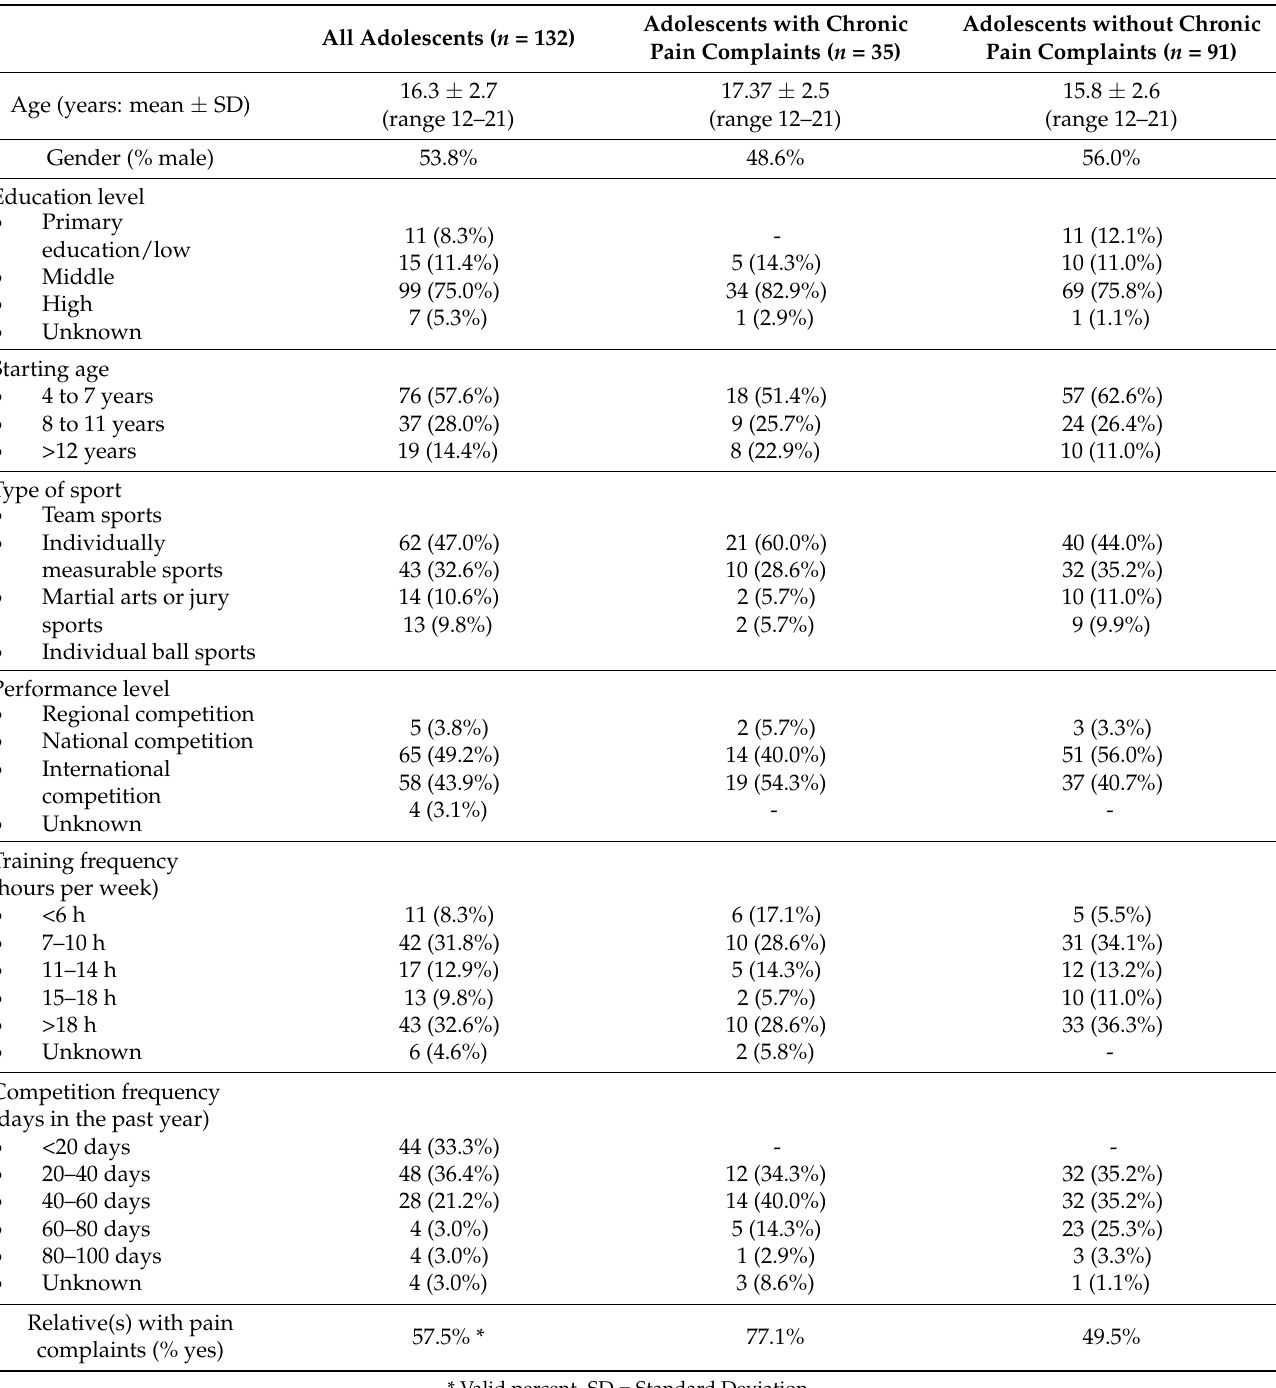
Table 1. Demographics, sport- and pain-related variables for participants with and without chronic pain. Adolescents with Chronic Adolescents without All Adolescents ( n = 132) Pain Complaints ( n = 35)